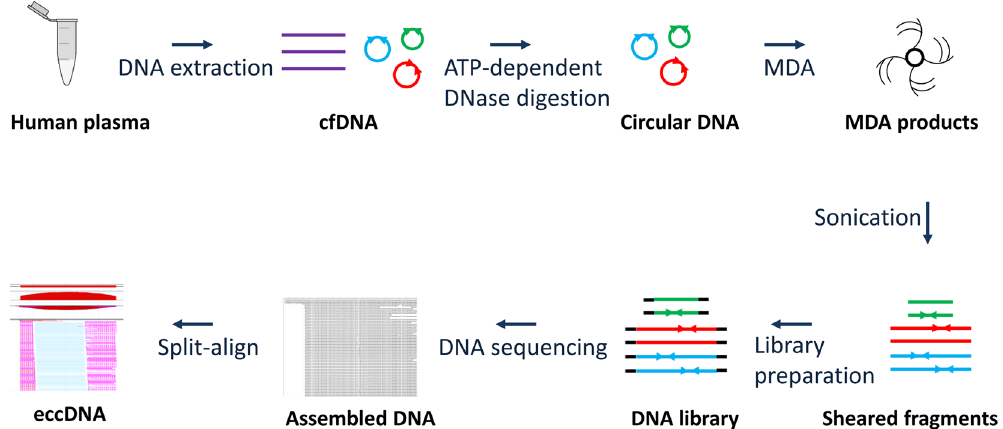
Figure 2. Flow chart of eccDNA preparation and sequencing data analysis. cfDNA was extracted from human plasma. Plasmid-Safe ATP-dependent DNase was used to remove the linear DNA. The DNase-resistant DNA (circular DNA) was further amplified using MDA method. The MDA products were sheared into 100–300 bp fragments, which were then used for library preparation and sequencing analyses. By removing mitochondrial sequence, the remaining sequences were aligned to human genome sequences. A split-read based method (Split-align) was used to determine the